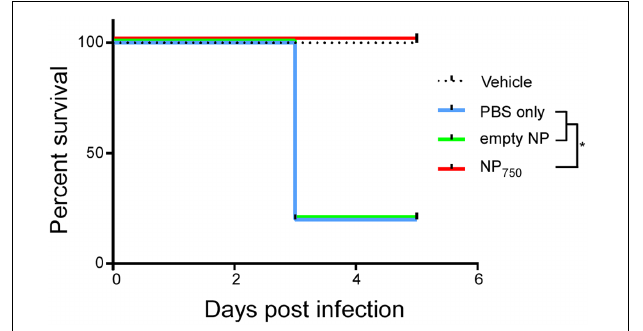
FIGURE 9 | Complete protection against C. difficile challenge in vaccinated mice. Various groups of mice were treated with an antibiotic cocktail and then challenged by C. difficile or PBS. Survival was monitored for 5 days. Vehicle: health control; PBS: infection control; NP: empty nanoparticle vaccination; NP 750 : NP-rTcdB vaccination. All data are representative of at least three independent experiments ( ∗ p ≤ 0.05, error bars indicate standard errors of the means; the data were analyzed by Kaplan–Meier survival